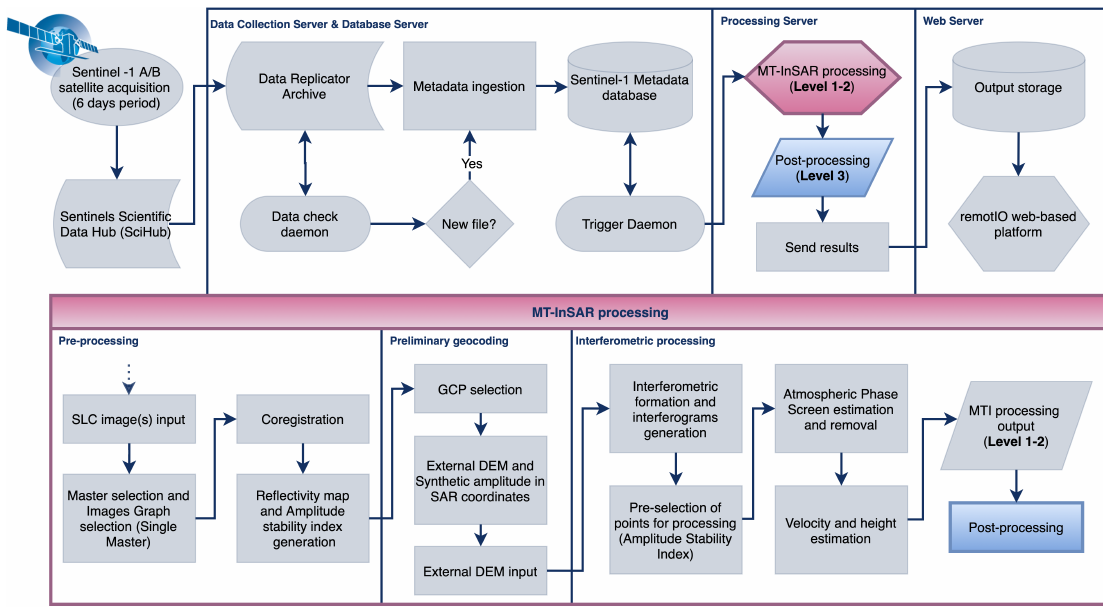
Figure 2. remotIO: auto-processing concept and flowchart